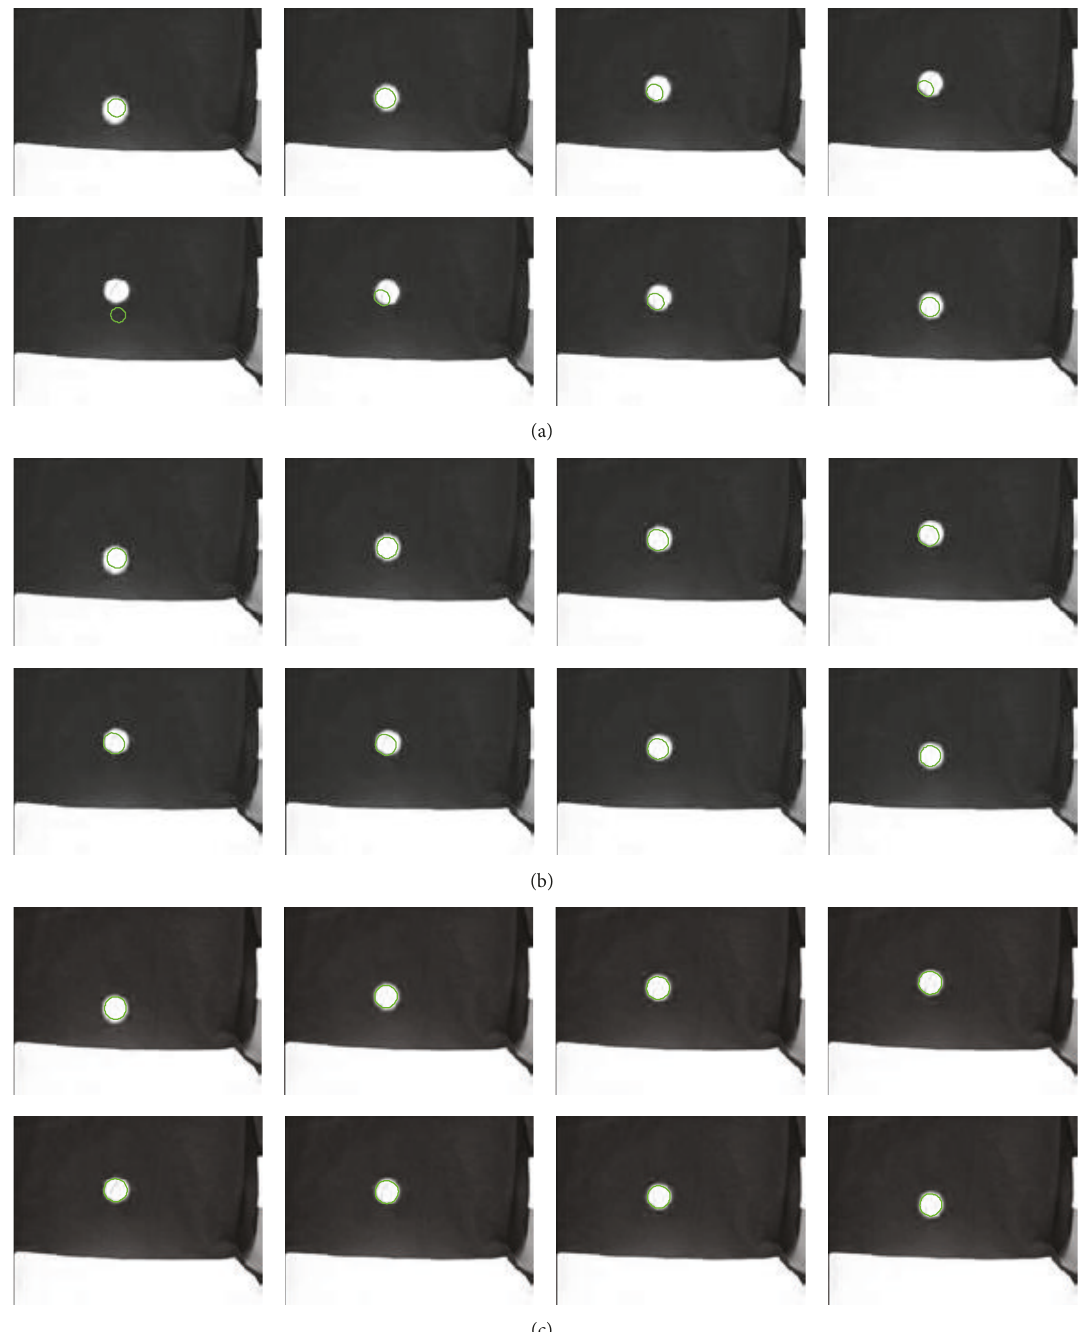
Figure 12: The results of object tracking (including eight images) with ACGS and the proposed method. (a) is the result with ACGS, (b) is the result with ACGS through careful initialization, and (c) is the result with the proposed